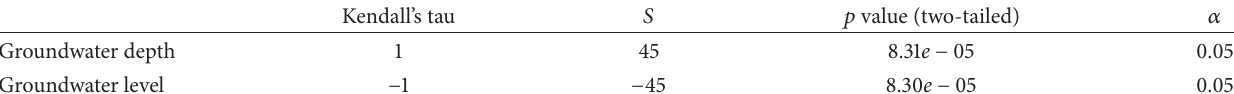
Table 2: Results of Mann-Kendall test of groundwater depth/level.